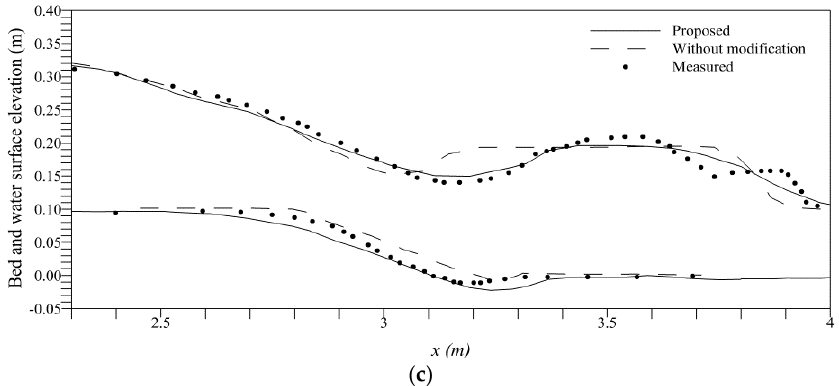
Figure 8. Numerical and experimental results of dam-break for Configuration 4: ( a ) t = 0.25 s; ( b ) t = 0.5 s; and ( c ) t = 1.0 s.